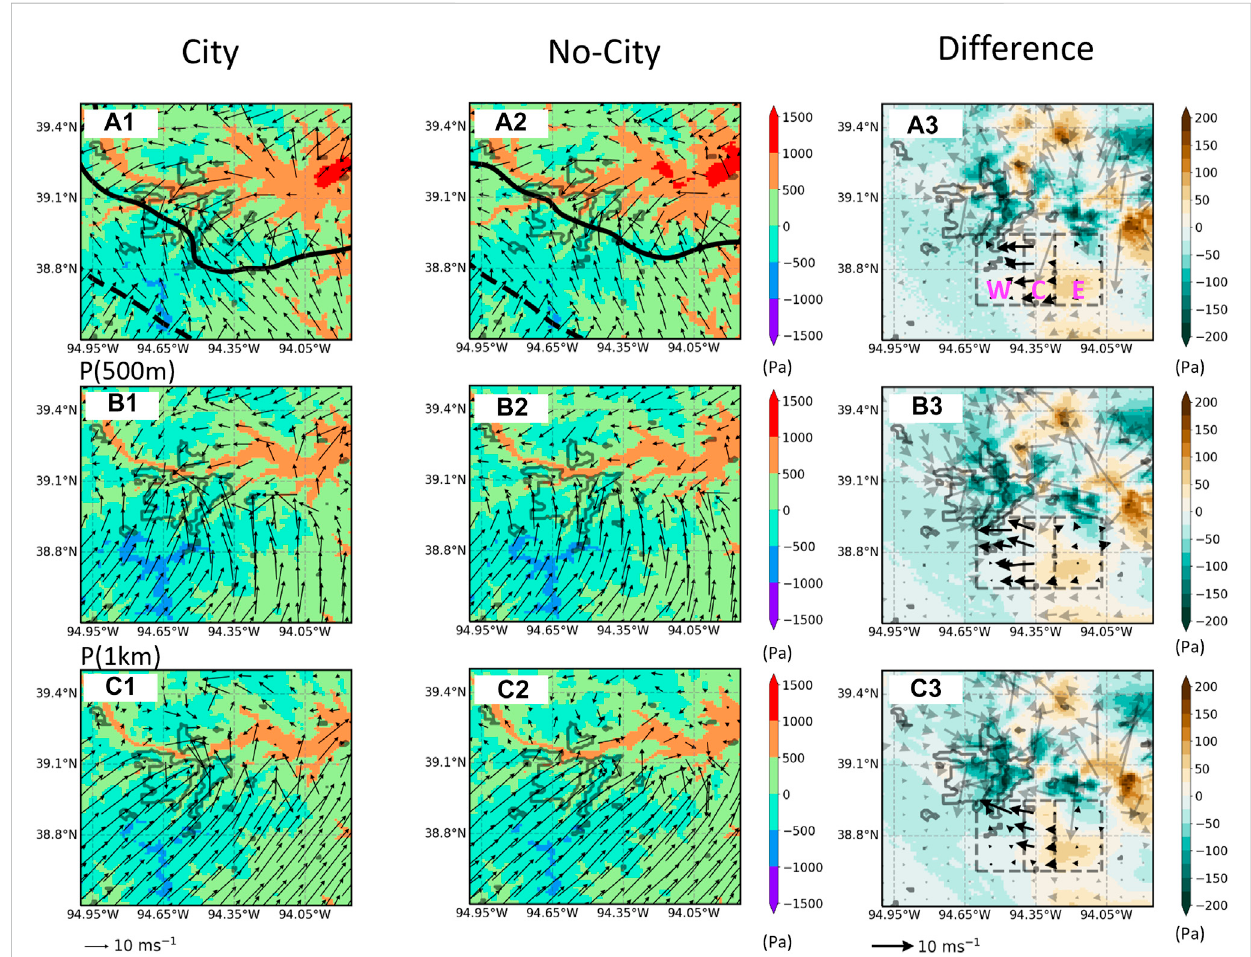
FIGURE 5 Pressure perturbation (contour; calculated by subtracting the mean pressure of the in- fl ow area (95.25 ° - 93.85 ° W, 38.5 ° - 39.75 ° N) and wind fi eld (barbs) at 100 m AGL for (A1) City, (A2) No-City, and (A3) the difference between City and No-City at 23:30 UTC. (B1 – B3) and (C1 – C3) are the same as (A1 – A3) , except for 500m and 1 km AGL. The black lines on (A1,A2) indicate the 33 ° C (dashed) and 30.5 ° C (solid) isotherms. The difference in winds is plotted for the storm-relative winds. The boxes on (A3,C3) are the same as those in Figure